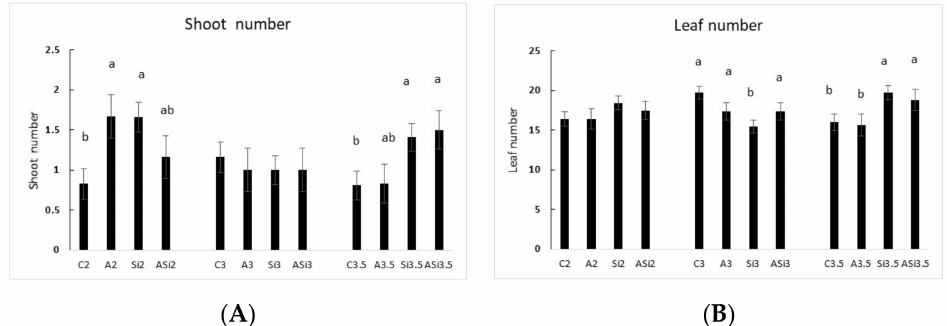
Figure 8. Shoot number ( A ) and leaf number ( B ) at the end of the trial for the C2 (foliar application with water and fertigation EC 2.0 dS m − 1 ), A2 (foliar application with Arthrospira platensis and fertigation EC 2.0 dS m − 1 ), Si2 (foliar application with Si and fertigation EC 2.0 dS m − 1 ), ASi2 (foliar application with Arthrospira platensis and Si, and fertigation EC 2.0 dS m − 1 ), C3.0 (foliar application with water and fertigation EC 3.0 dS m − 1 ), A3.0 (foliar application with Arthrospira platensis and fertigation EC 3.0 dS m − 1 ), Si3 (foliar application with Si and fertigation EC 3.0 dS m − 1 ), ASi3 (foliar application with Si and Arthrospira platensis, and fertigation EC 3.0 dS m − 1 ) treatments; C3.5 (foliar application with water and fertigation EC 3.5 dS m − 1 ), A3.5 (foliar application with Arthrospira platensis and fertigation EC 3.5 dS m − 1 ), Si3.5 (foliar application with Si and fertigation EC 3.5 dS m − 1 ), and ASi3.5 (foliar application with Si and Arthrospira platensis, and fertigation EC 3.5 dS m − 1 ) treatments. Di ff erent letters indicate significant di ff erences between treatments at the p < 0.05 level using the LSD test. Values are the means of 12 plants. Error bars show standard deviations.